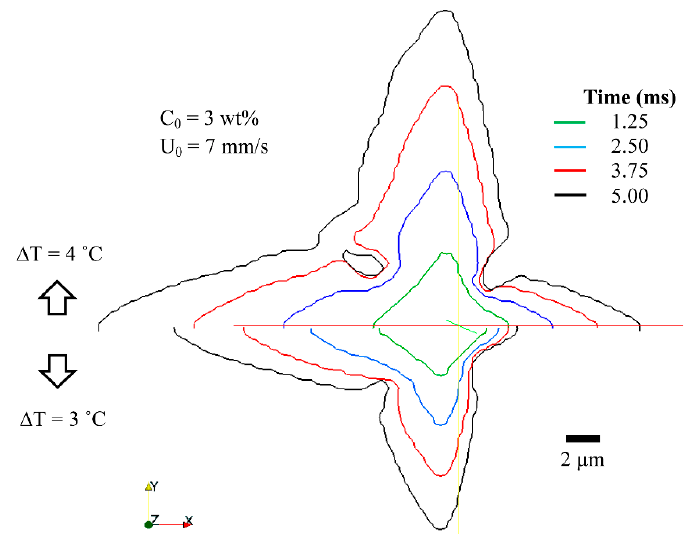
Figure 11. Comparison of dendritic morphologies growing in melts with different degrees of undercooling. Top: ∆ T = 4 °C; and bottom: ∆ T = 3 °C. Different colors represent different simulated times.